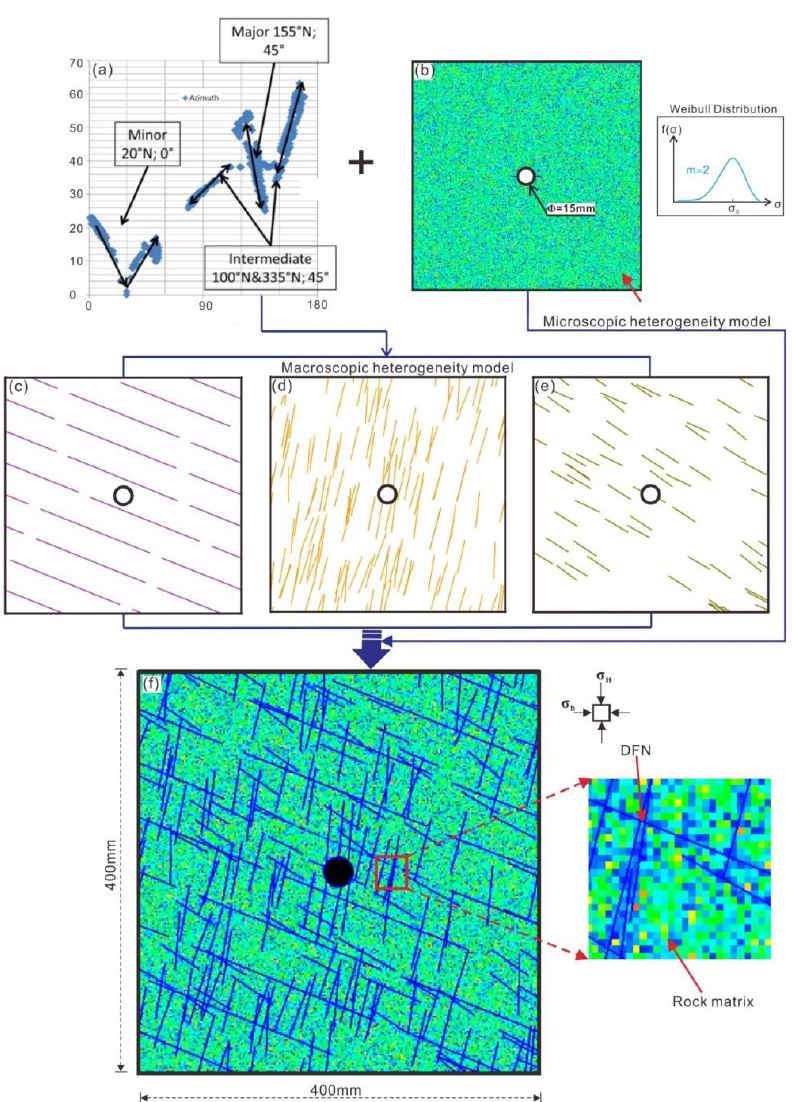
Figure 2. Numerical model setup: ( a ) statistical results of nature fractures by Gui et al. [8]; ( b ) the microscopic heterogeneity background model, the failure-strength and elastic modulus obeys Weibull distribution; ( c )–( e ) the developed discrete fracture network (DFN) model; ( c ) and ( d ) are the Beacher Model; and ( e ) is the Parallel Deterministic Model; ( f ) the calculation model in this paper, considering the macroscopic and microscopic heterogeneity characteristics, simultaneously.